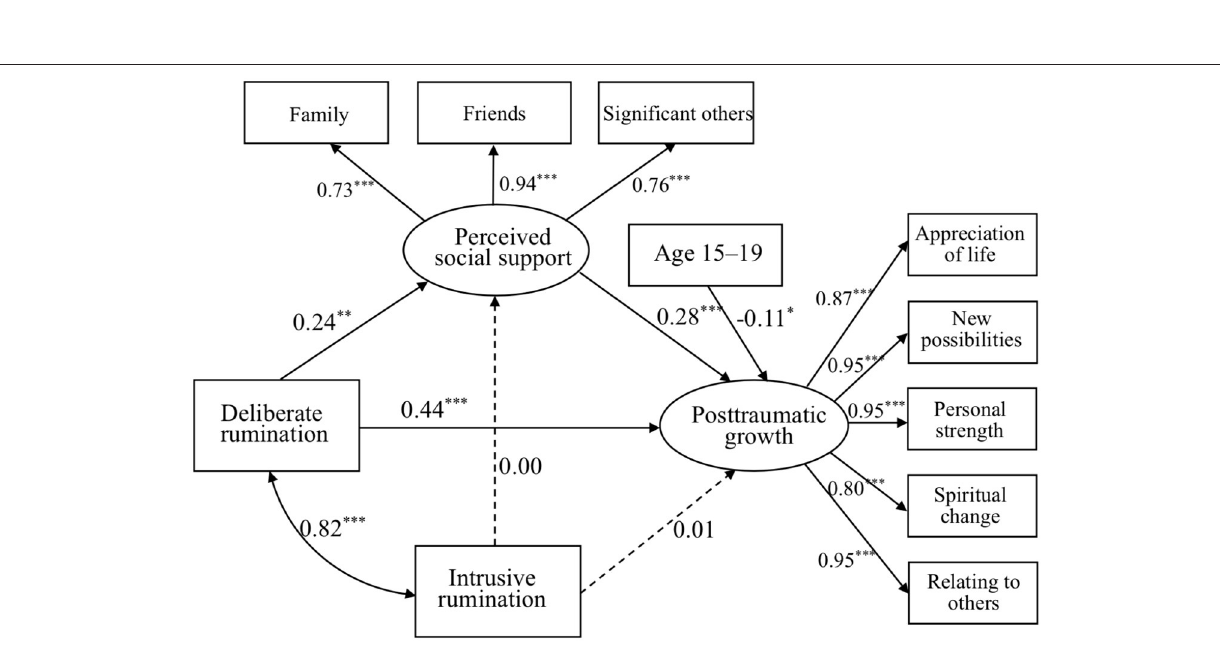
interactions of intrusive × deliberate rumination ( t = − 2.37, p < 0.05) and intrusive rumination × PSSSO ( t = 2.00, p =